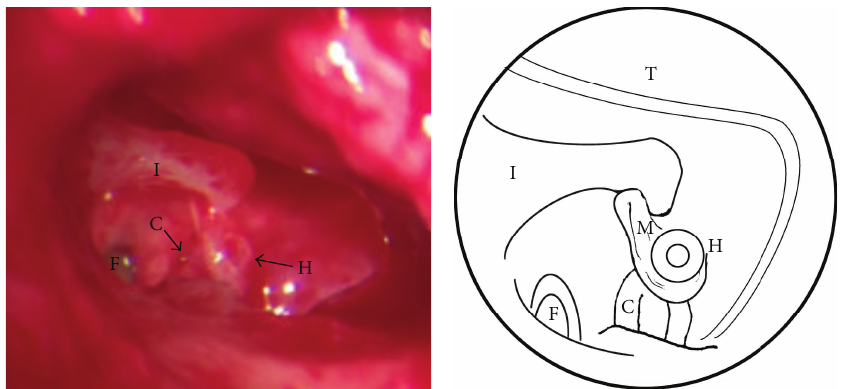
Figure 2: Intraoperative view of the middle ear (photo and diagram). After performing tympanotomy a disconnection between stapes superstructure and incus with a normal stapes footplate is observed. I: long process of the incus; H: head of the stapes; C: stapes crura; F: stapes footplate; T: tympanomeatal flap; M: mucosal folds.